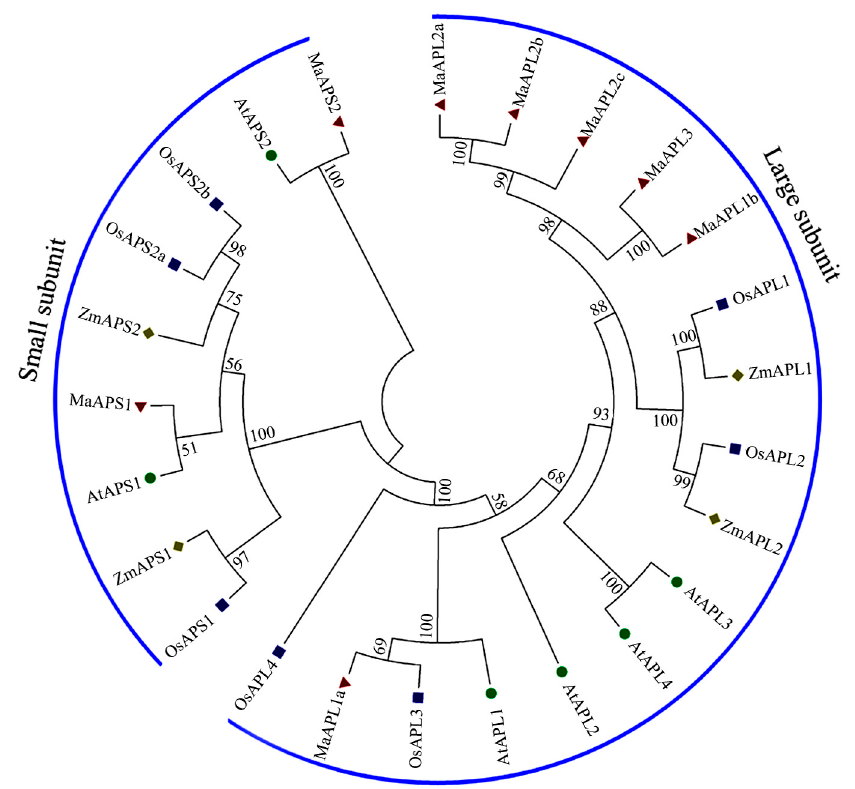
Figure 1. Phylogenetic analysis of the AGPases from Arabidopsis, rice, and banana. The Neighbor-joining tree was drawn using MEGA5.0 with 1000 bootstraps. Two subgroups were identified and classified as large subunit and small subunit. The circle, square, and triangle represent AGPase proteins from Arabidopsis, rice, and banana, respectively.